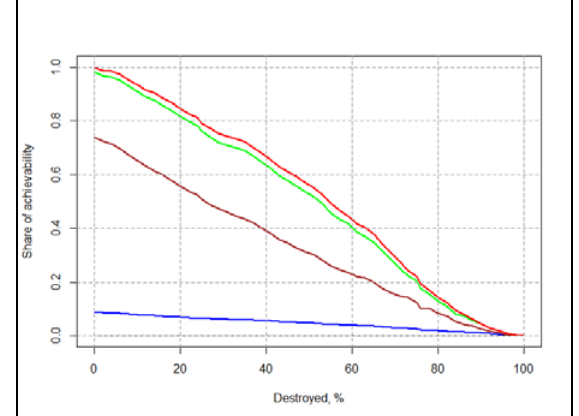
Fig. 3. Dependence of a proportion of successive transaction on percentage of nodes